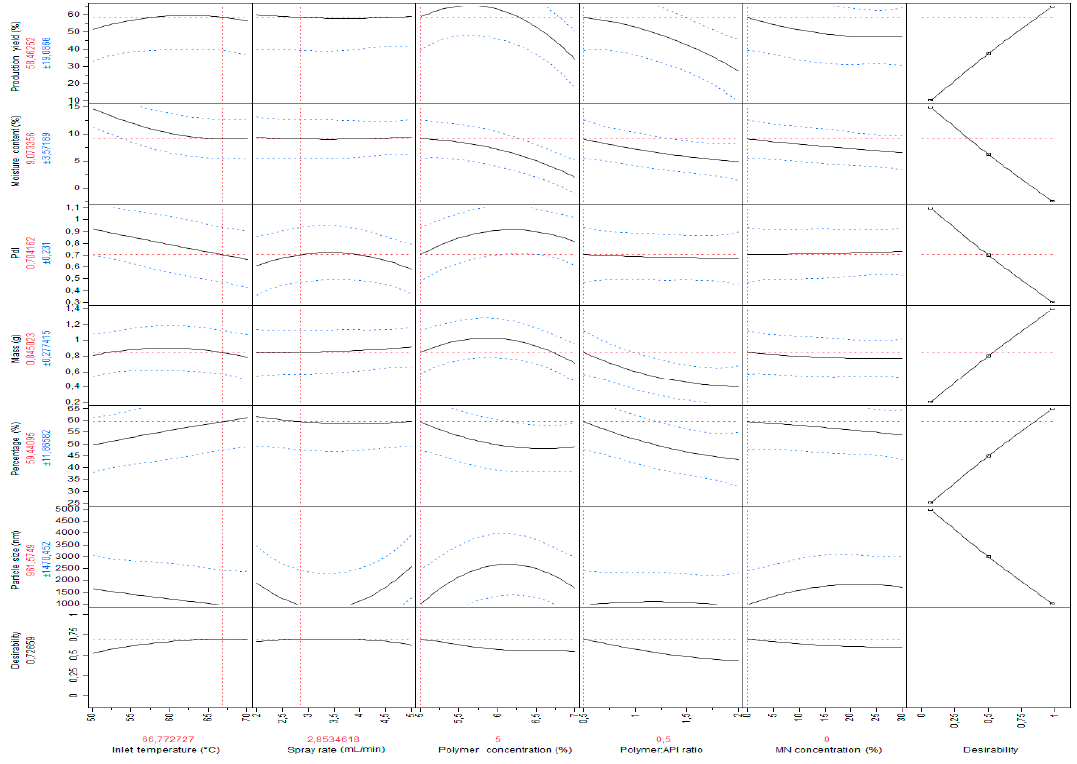
Figure 1. Prediction profiler with maximize desirability function used.